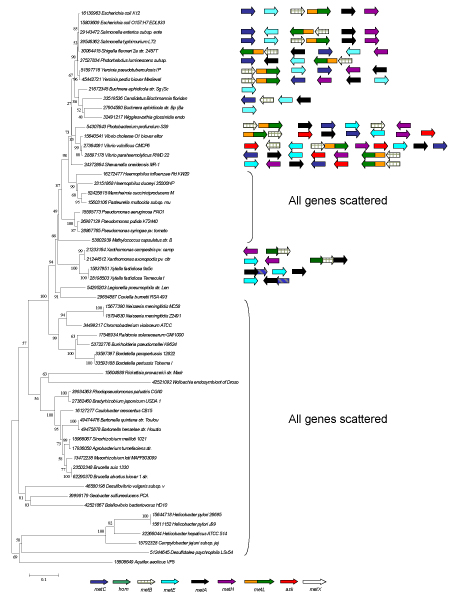
Gene organization of methionine genes. Structure and organization of methionine biosynthetic genes of the 58 proteobacteria correlated with their phylogenetic position as established by RpoD analysis.